Question: Describe this figure in one sentence.
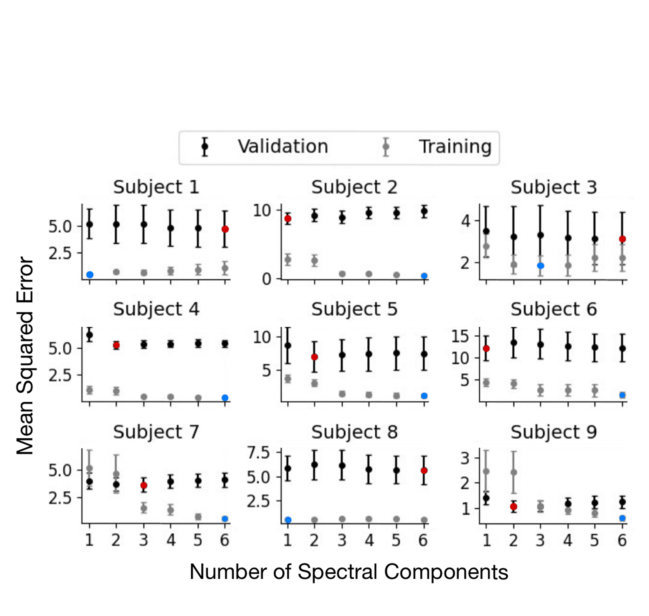
Answer: Training (gray) and validation (black) MSE ± Standard Error of the spectral model as a function of the number of spectral components (m), presented for each subject and averaged across stimulus conditions. The minimum training MSE is highlighted in blue, and validation in red.